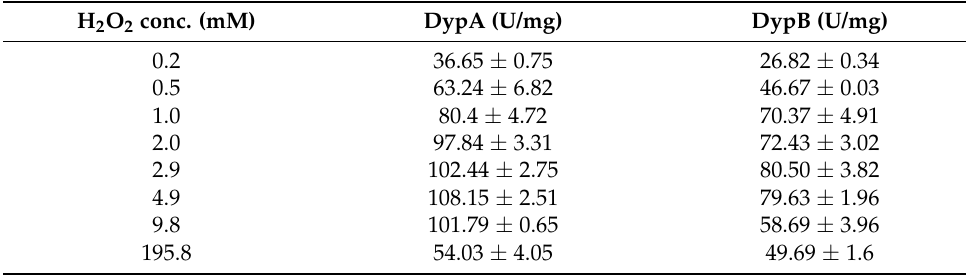
Table A5. Specific activity of DypA and DypB at different H 2 O 2